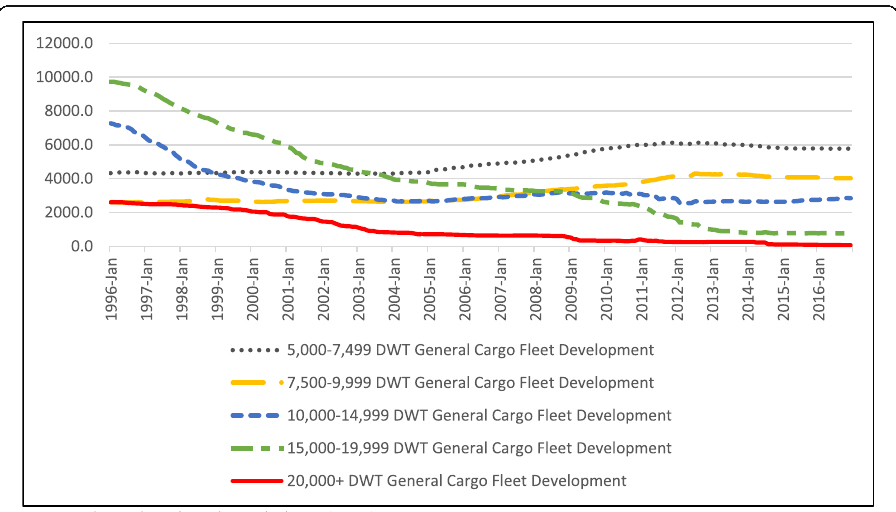
Fig. 4 Number of General Cargo Ships ordered by size class. Source: the authors based on Clarkson